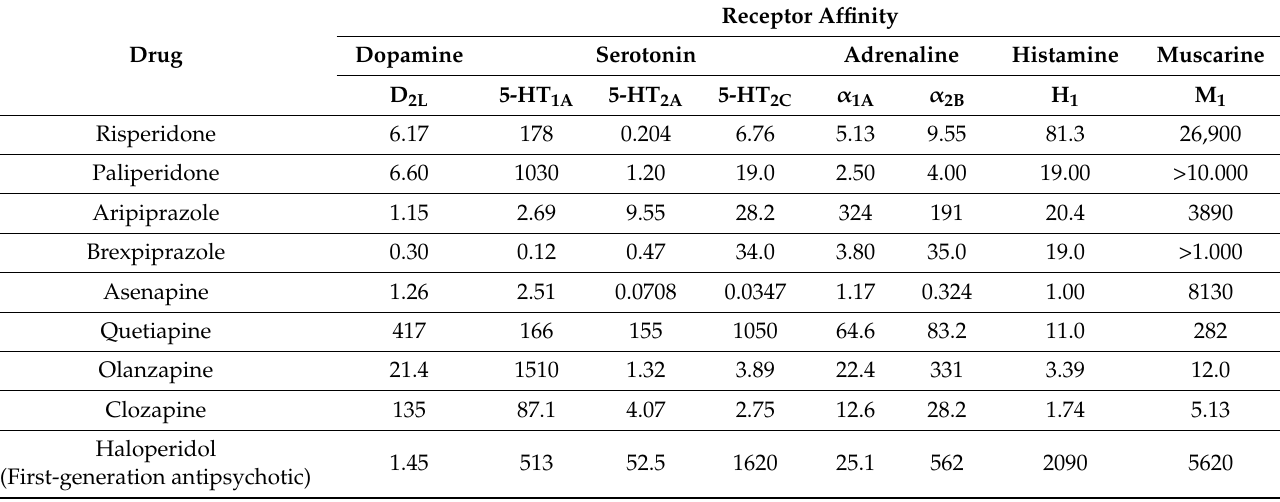
Table 2. Comparison of receptor affinities of selected second-generation antipsychotics